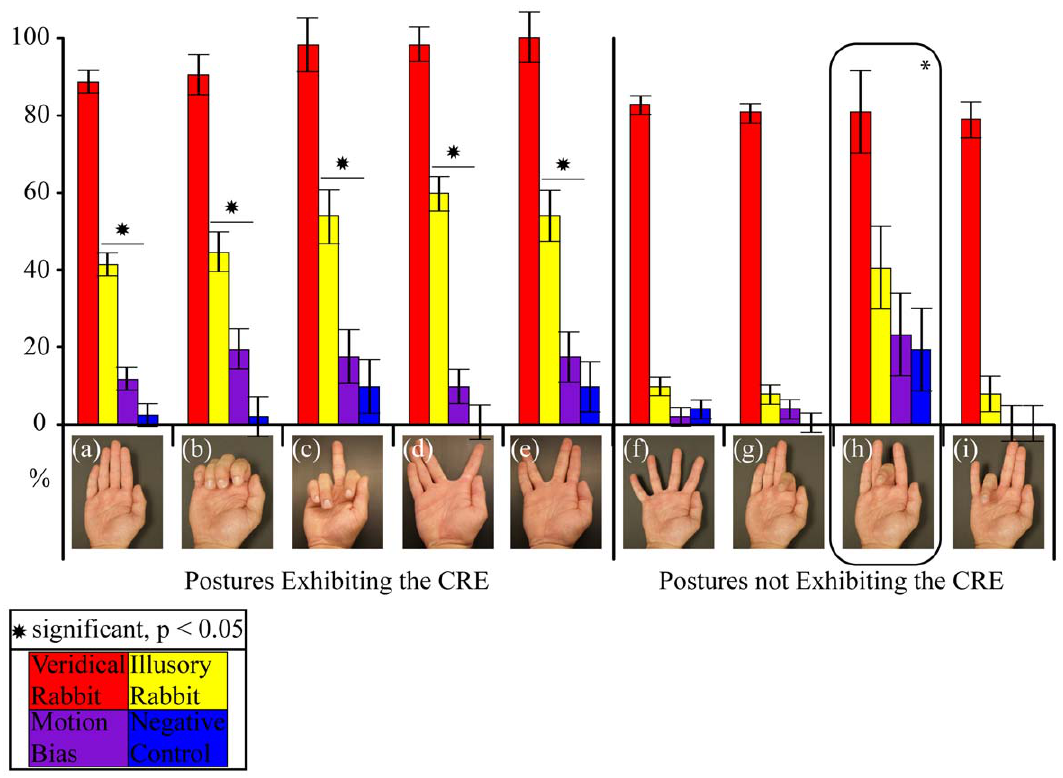
Figure 2. Percentage of trials where subjects indicated their middle fingertip was stimulated. Mean percentage of responses where subjects indicated that their middle fingertip had been stimulated; in response to, ‘‘Did the preceding stimulus train contain a stimulus on the middle fingertip?’’ Error bars indicate the standard error (s.e.m.) of each stimulus train in each posture. * indicate significant differences in subject perception of stimuli on the middle fingertip between the Illusory Rabbit and Motion Bias Trains for a particular posture as determined via Fisher LSD tests, a , 0.05, (a) All-Adducted ( n =14), (b) All-Flexed ( n =4), (c) Middle-Extended ( n =4), (d) Index-Abducted ( n =4), (e) Vulcan ( n =4), (f) All-Abducted ( n =4), (g) Index-Flexed, (h) Middle-Flexed ( n =14), (i) Ring-Flexed ( n =4), where each n represents a subject response average of 13 trials per posture and stimulus train.